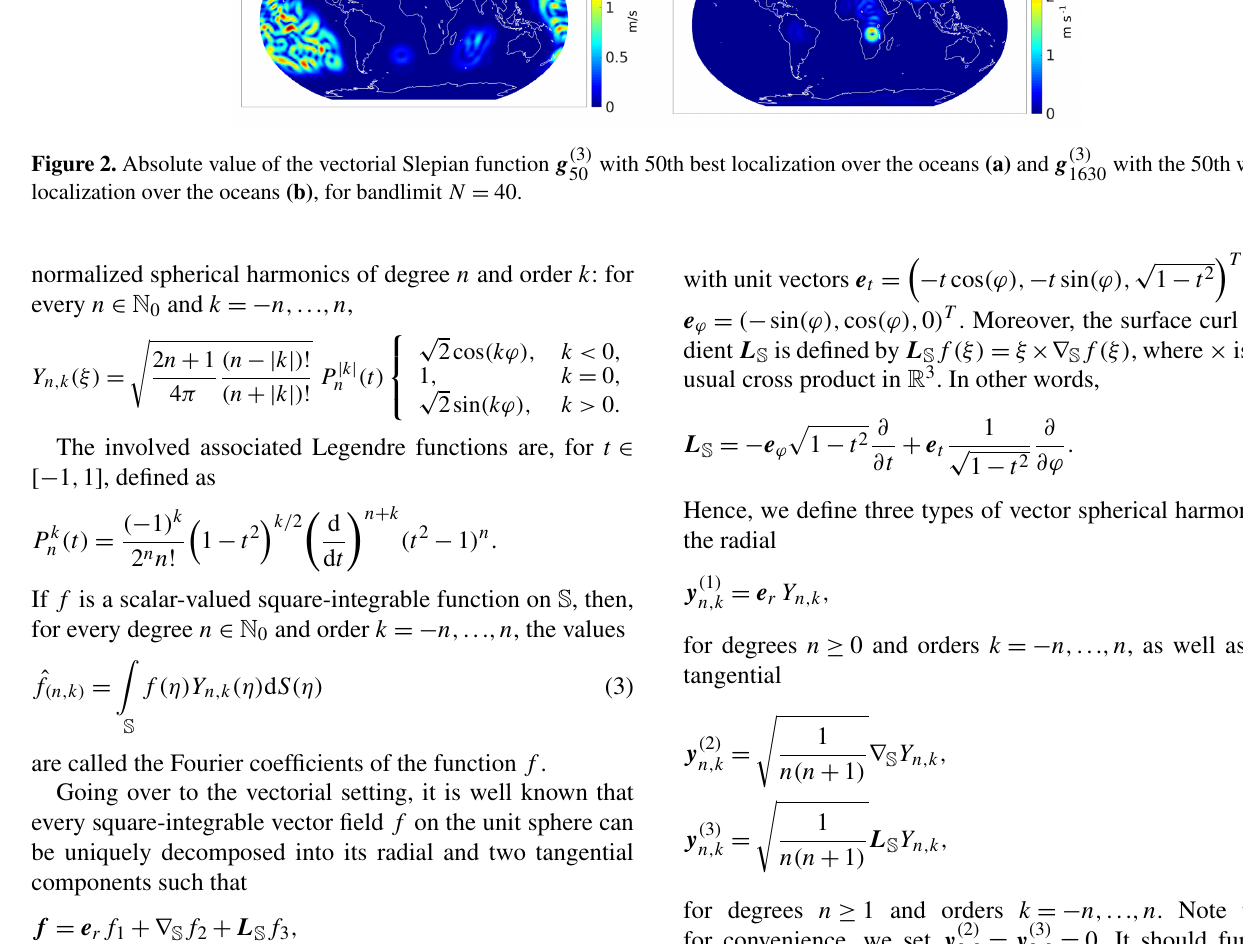
∈ S is marked by a white cross. 1